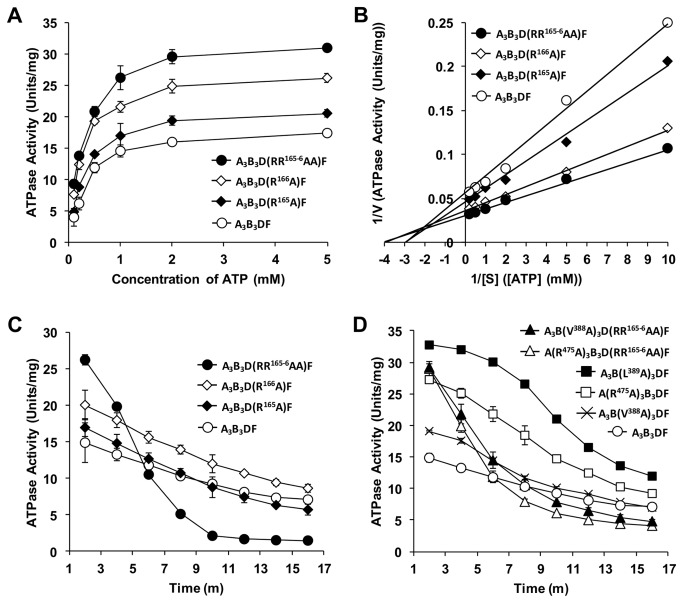
ATPase activities and their stability in mutant A3B3DF complexes of

E

. hirae
 V-ATPase.ATPase activities of the mutants were measured using an ATP regeneration system as described in Materials and Methods. A, ATPase activities of the central-axis D subunit mutants measured using various concentrations of ATP. B, Lineweaver-Burk plots of the ATPase activities from Figure 4A used for calculating K
m and V
max values for the D mutants. C-D, Stability of ATPase activities of mutant A 3B3DF complexes. ATPase activities were measured in the presence of 1 mM ATP. Filled
circles, A 3B3D(RR165-6AA) F; open
diamonds, A 3B3D(R166 A) F; filled
diamonds, A 3B3D(R165 A) F; filled
triangles, A 3B(V388 A) 3D(RR165-6AA) F; open
triangles, A(R475 A) 3B3D(RR165-6AA) F; filled
squares, A 3B(L389 A) 3DF; open
squares, A(R475 A) 3B3DF; open
crosses, A 3B(V388 A) 3DF; and open
circles, wild-type A 3B3DF.